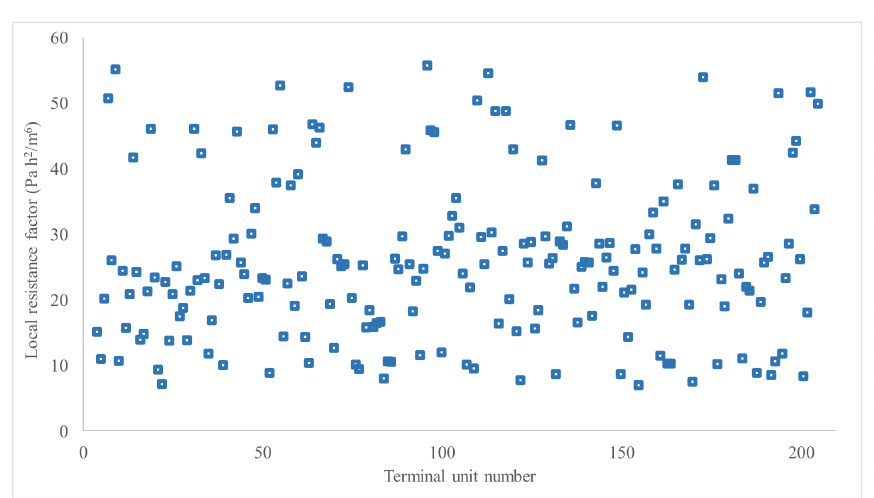
Figure 10. The calibrated value r 2 of all terminal